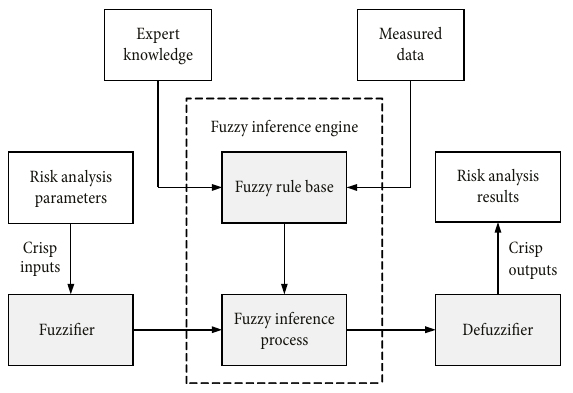
Fig. 3. An overview of the FLo system